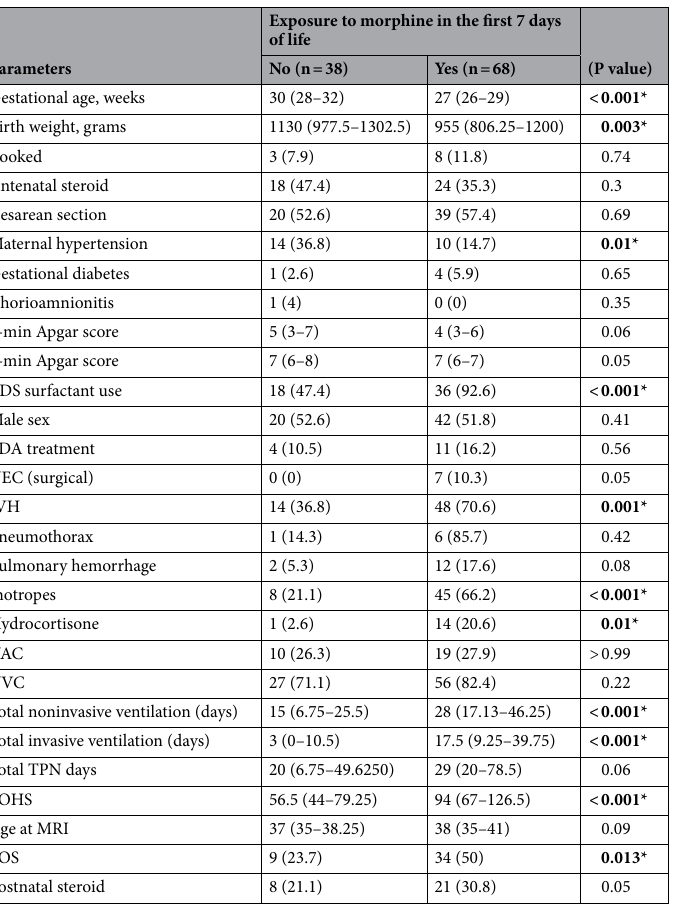
Table 1. Demographic and clinical characteristics of the mothers and premature infants by morphine exposure in the first 7 days of life (n = 106). Data are presented as median (IQR), or number (%), as appropriate. Significant values are in bold. RDS Respiratory distress syndrome, PDA Patent ductus arteriosus, NEC necrotizing enterocolitis, IVH Intraventricular hemorrhage, UAC umbilical arterial catheter, UVC umbilical venous catheter, TPN Total parenteral nutrition, LOHS Length of hospital stay, MRI magnetic resonance imaging, LOS Late onset sepsis. *Statistically significant at 5%